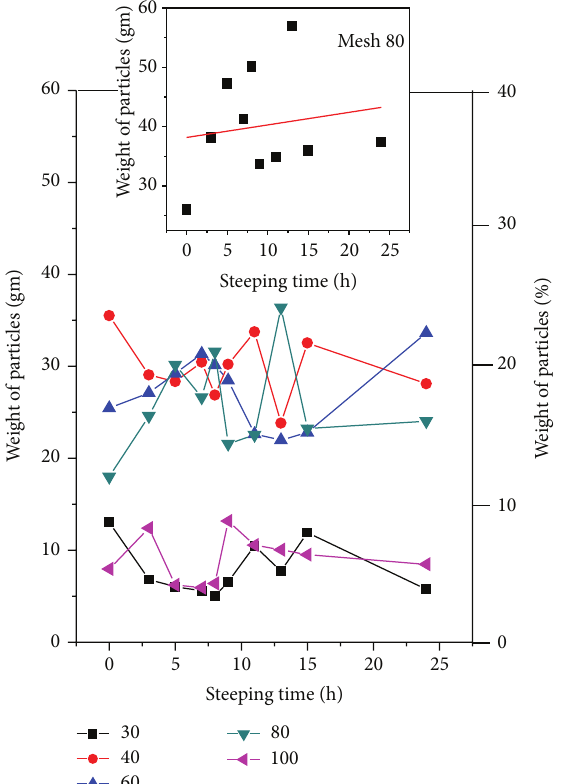
Figure 3: Calcium percentage (CP), absorbed by the PSD from the alkaline solution, as a function of ST for all the meshes used. The inset exhibits the mean CP averaged on 40, 60, and 80 (black squares) and 30 and 100 (green triangles), as a function of